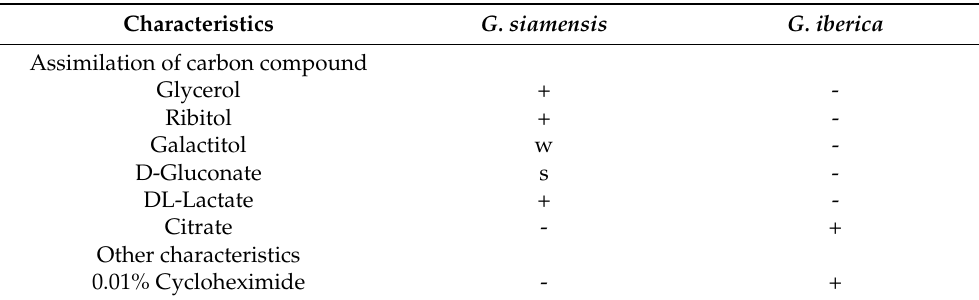
Table 5. Phenotypic characteristics that differentiate Goffeauzyma siamensis sp. nov. from its closest species, G. iberica